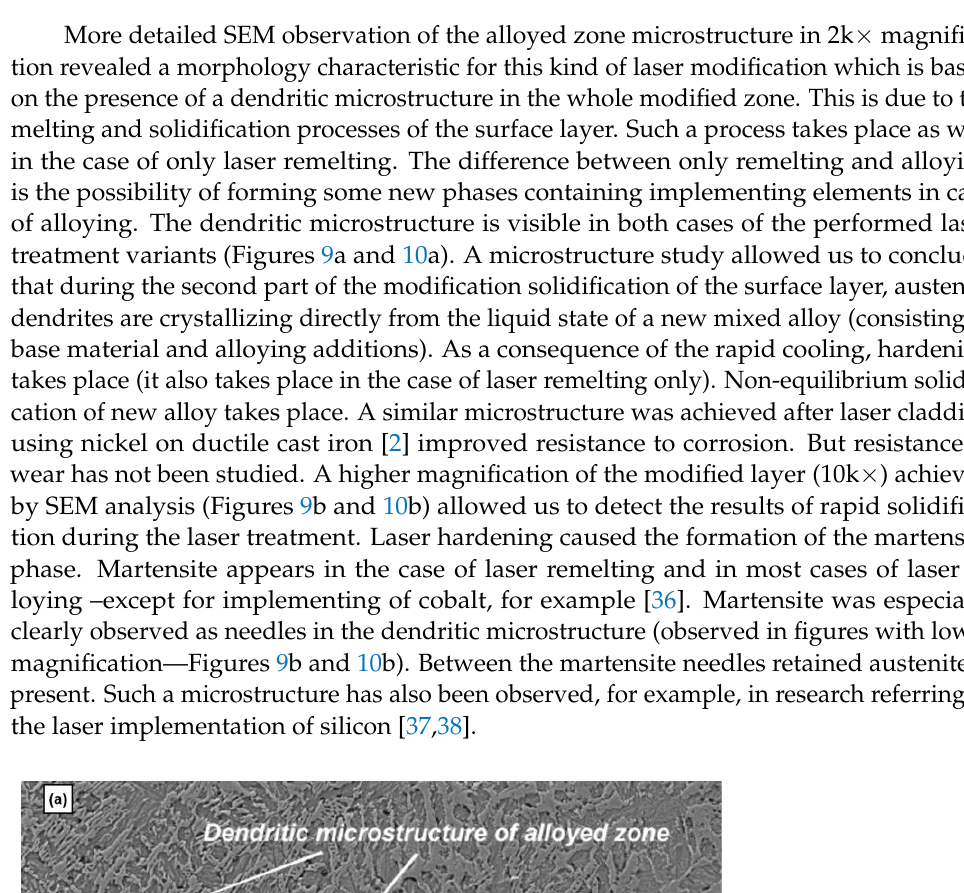
Figure 8. Microstructure of the surface layer of the untreated cultivator coulter (scanning electron microscope, etched with nitric acid).